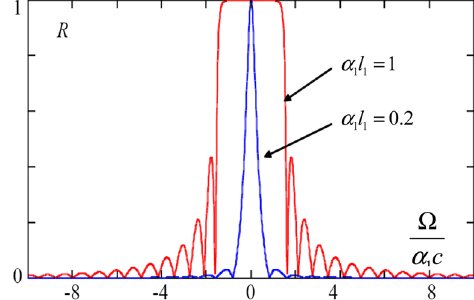
FIG. 2. (Color) Reflection coefficient vs frequency in the coupled-wave model: (cid:3) ¼ 0